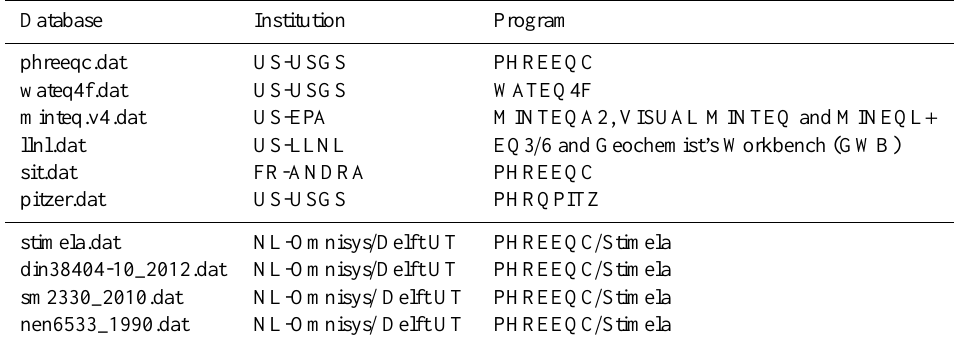
Table 4. Databases in the PHREEQC data format for calculating chemical equilibria in